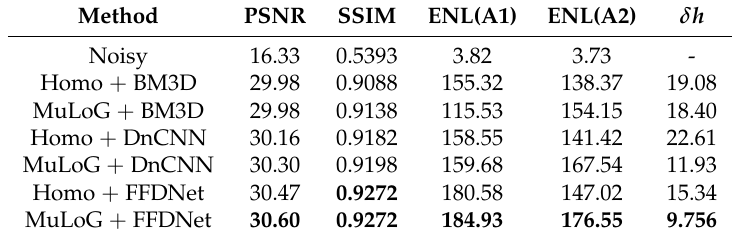
Table 2. The quantitative comparison of different methods for simulated SAR image with L = 4.